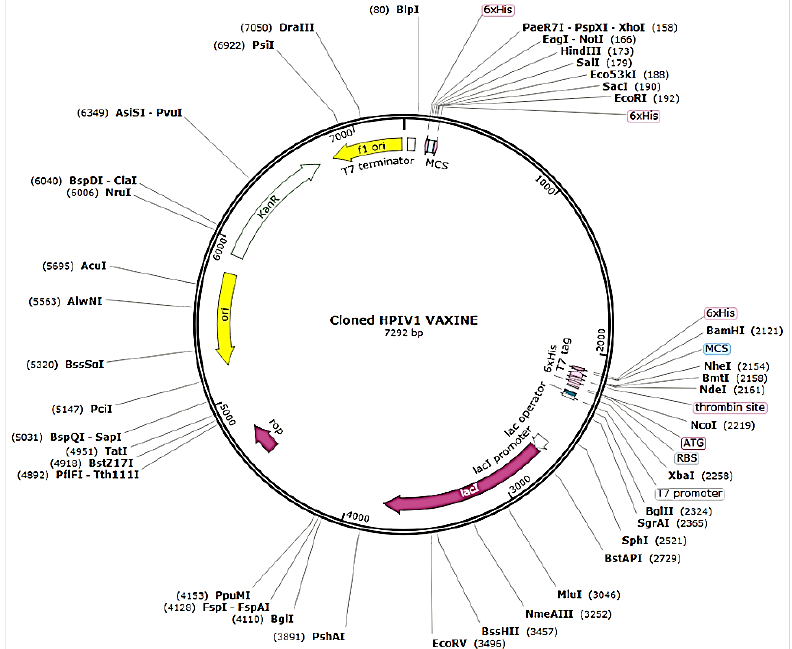
Figure 6. Sequence adaptation predicted via JCAT.